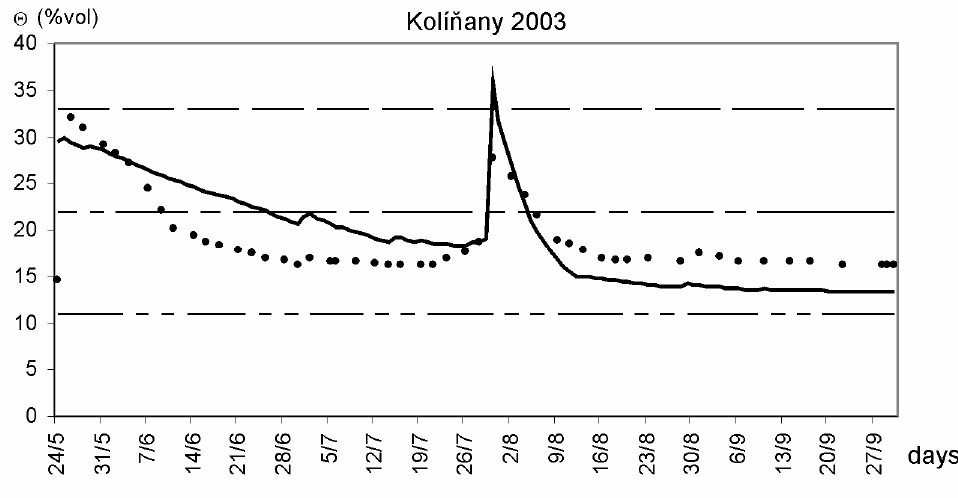
Fig 2. Measured and simulated values of volumetric soil water content in study area of Kolí ň any in 2003